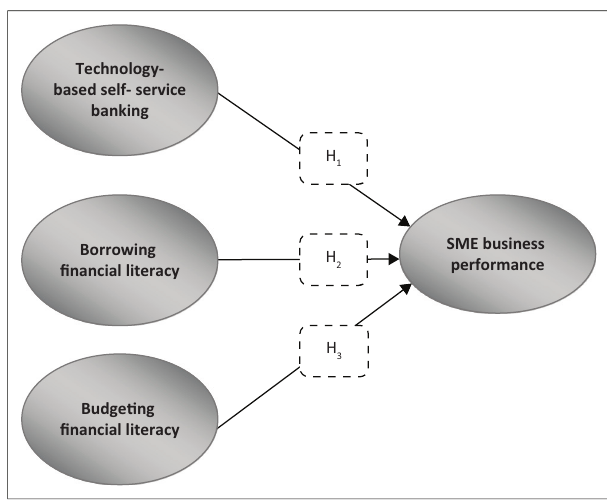
FIGURE 1: Conceptual framework.